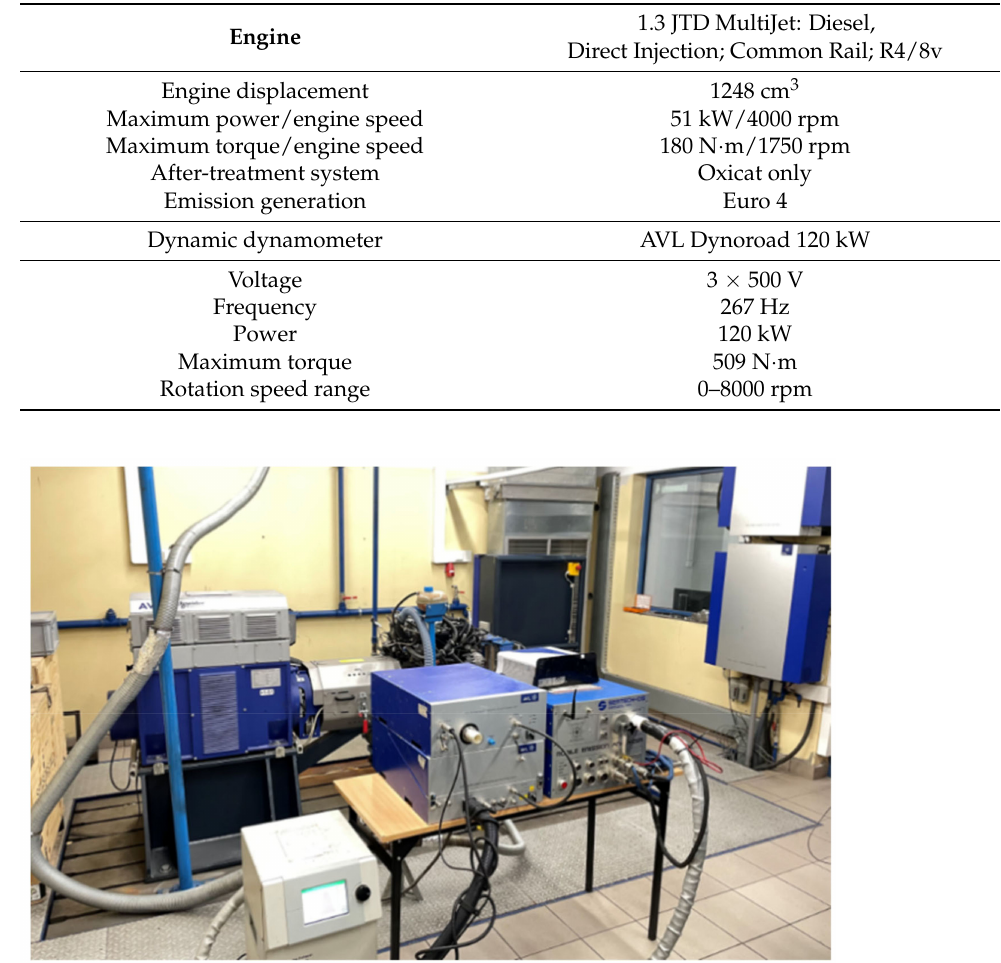
Table 1. Technical specifications of the laboratory test stand.